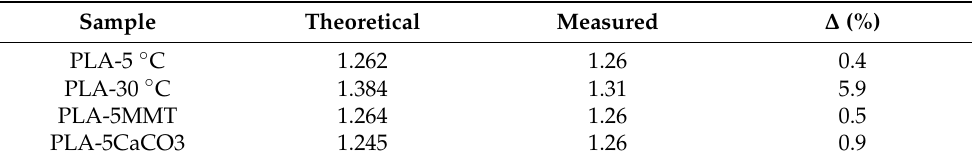
Sample Table 2. Calculated (relating to the rule of the mixture) and measured densities.